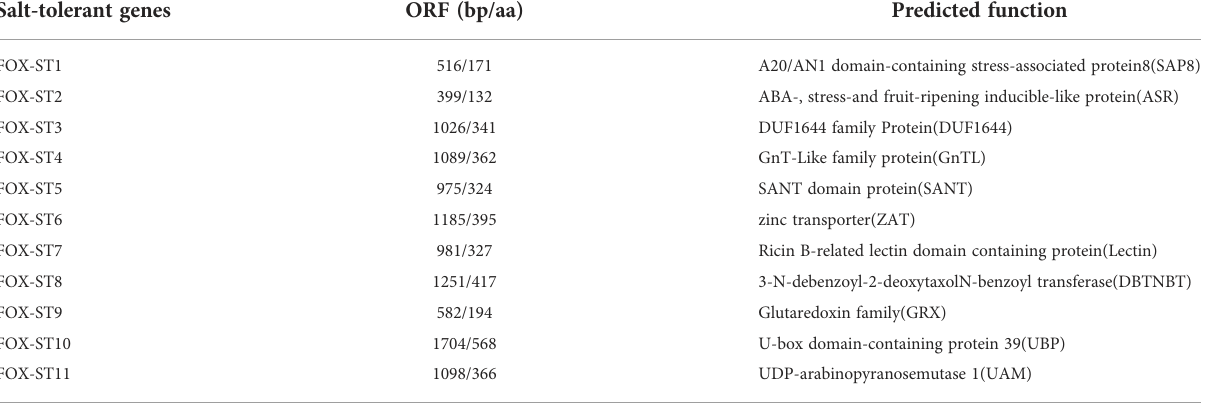
TABLE 2 Sequence analysis and function prediction of candidate salt-tolerance